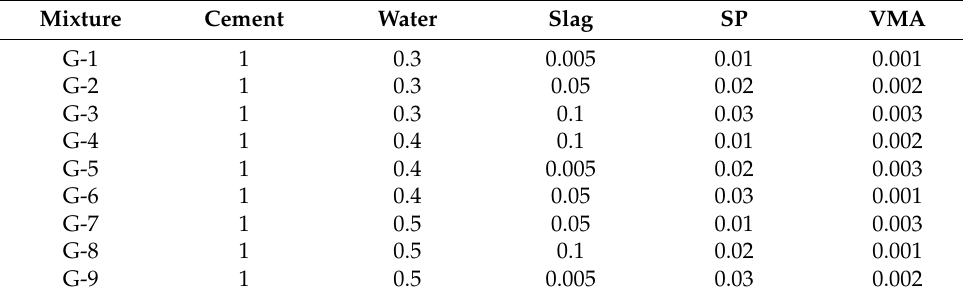
Table 4. Ratios of nine different grouts Taguchi orthogonal array L9 (4) .